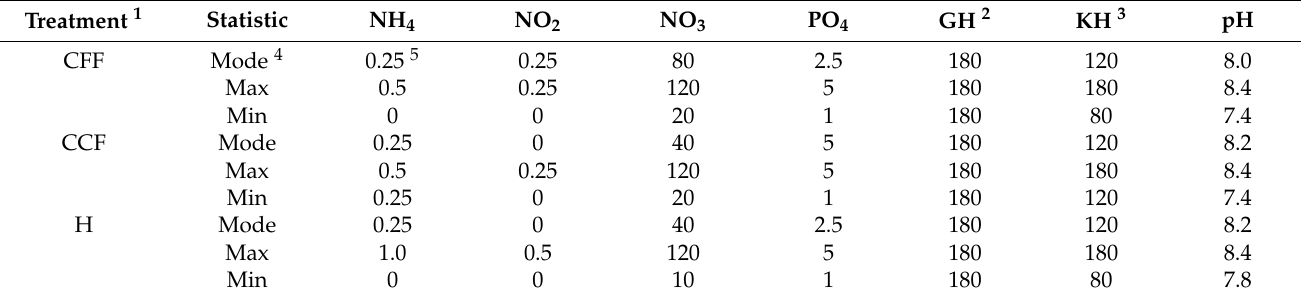
Table 2. A comparison of field-measured water chemistry parameters in aquaponics systems with three different fish food